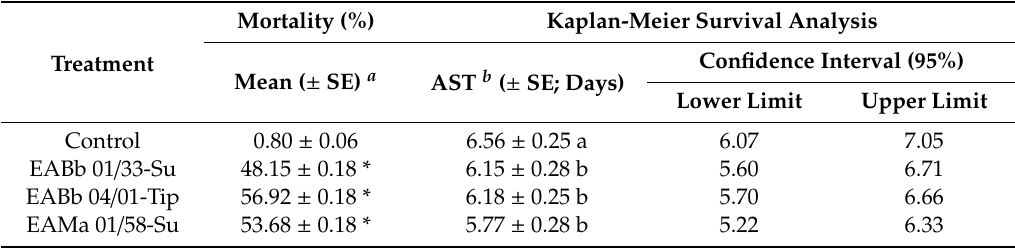
Table 2. Susceptibility of A. gossypii adults to entomopathogenic fungal isolates after exposure to leaves with conidia on their surfaces and which were also endophytically-colonized by those